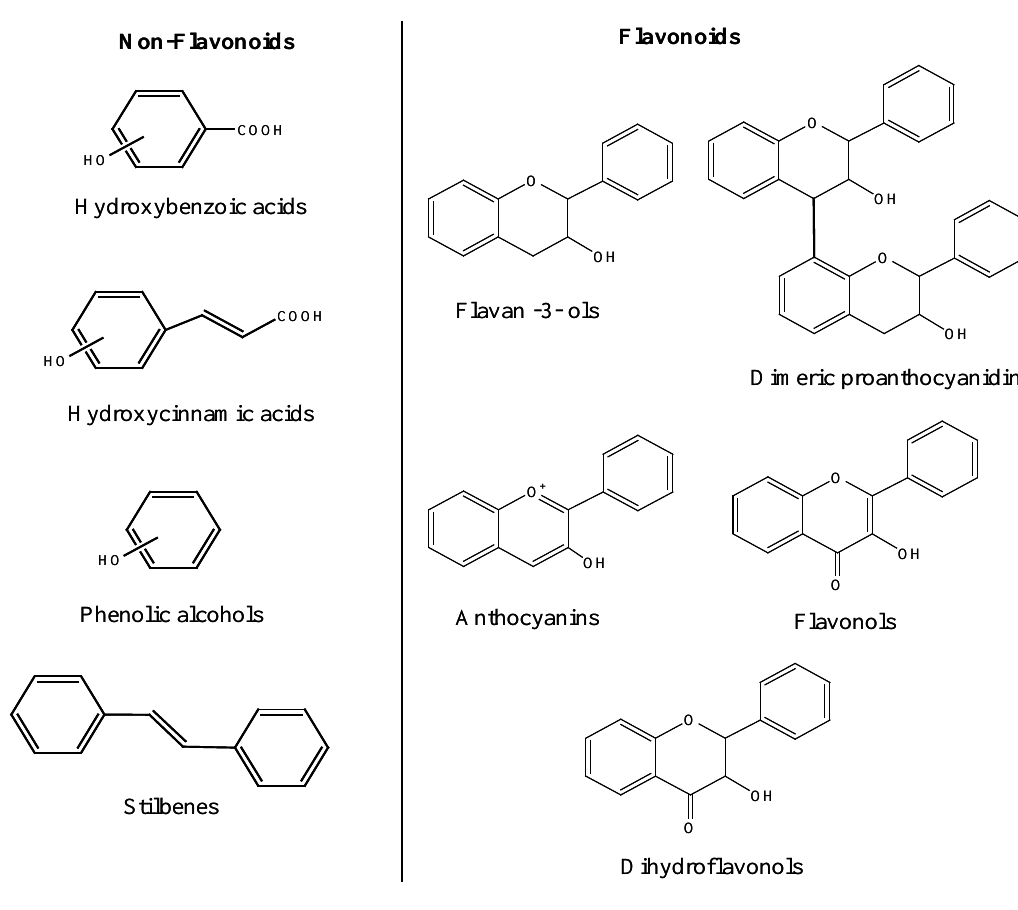
Figure 1. Common phenolic compounds in